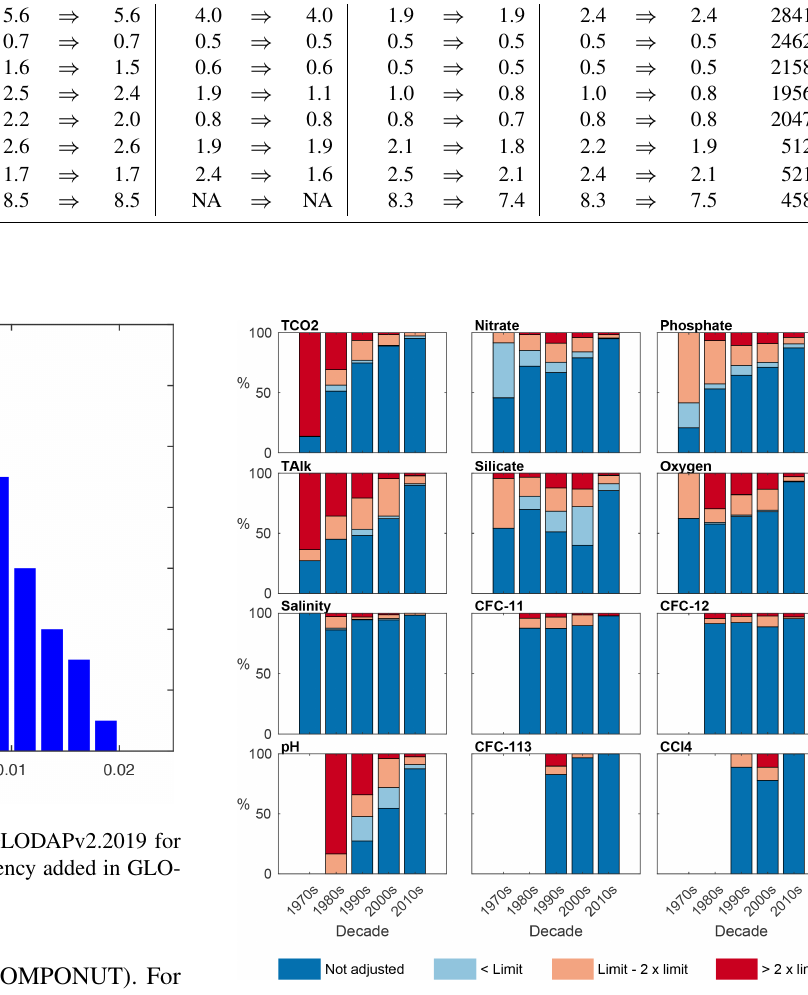
Figure 8. Magnitude of applied adjustments relative to minimum adjustment limits (Table 3) per decade for the 946 cruises included in